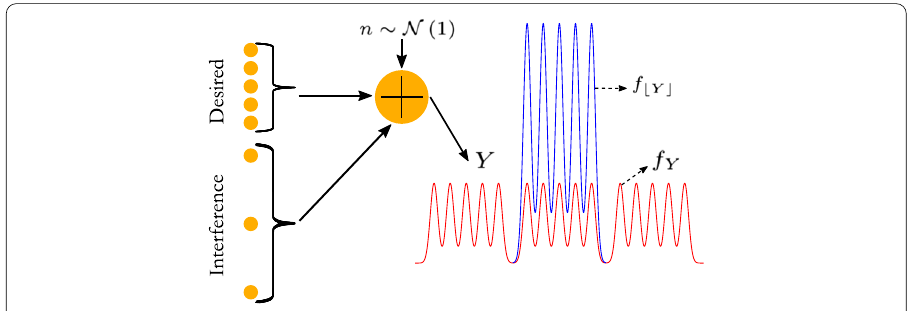
Fig. 2 Discrete interference. The red curve is the pdf of the received signal. The blue curve is the pdf of the received signal after modulus with the interference constellation ; this is the same as if there had been no